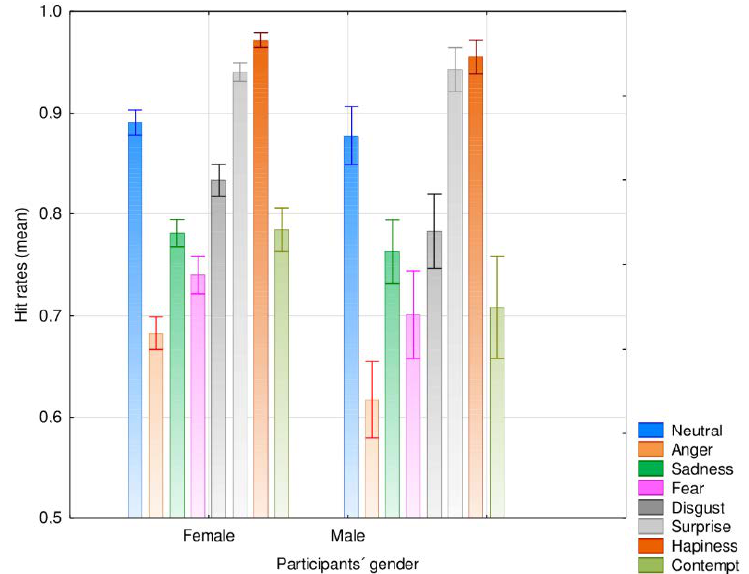
Figure 3. Mean agreement rates for the different emotional categories depending on the participants’ gender (error bars represent 95% CI).